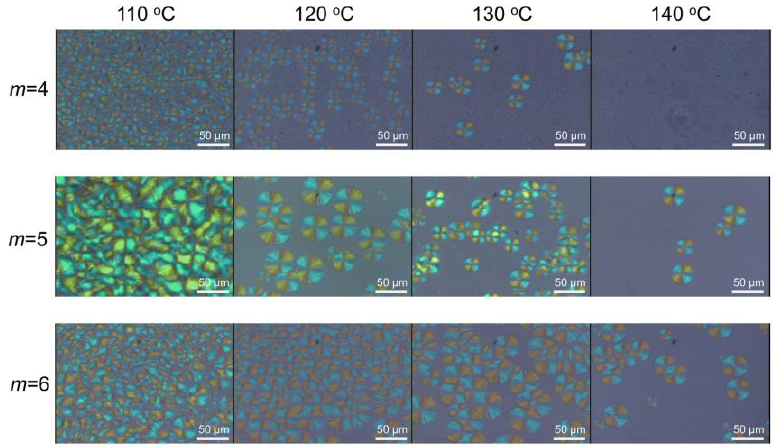
Figure 5. Polarized optical microscope images of the SPN- m scLAOs ( m = 4, 5 and 6) held at a specified temperature for 10 min after melted at 220 °C.